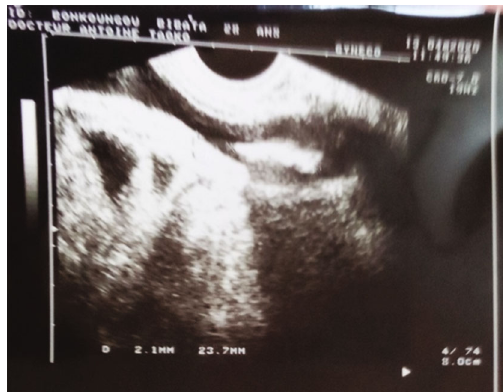
Figure 1: Hyperechoic image of intrauterine device in the bladder on pelvic ultrasonography.